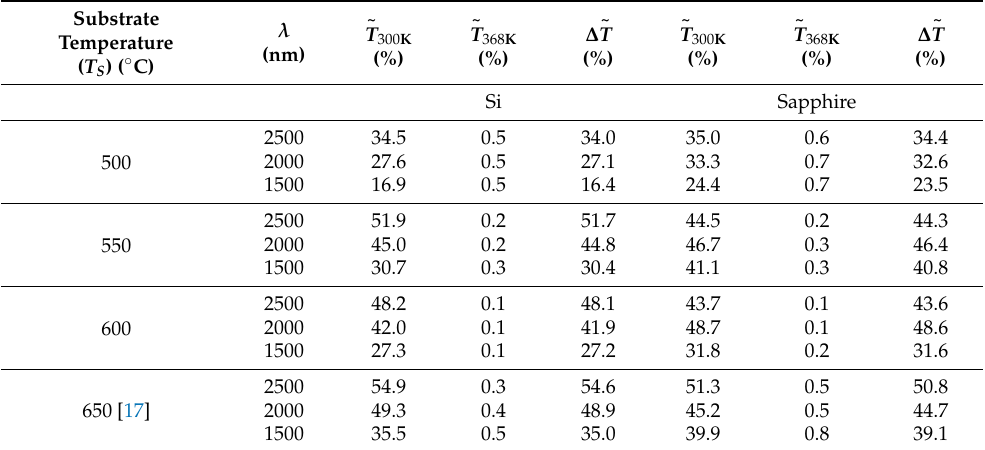
Table 3. Optical transmittance ( (cid:101) T ) and transmittance contrast ( ∆ (cid:101) T ) values of VO 2 films prepared at different substrate temperatures ( T S ) obtained at 300 K (insulating) and 368 K (metallic) for λ = 1500 nm, 2000 nm and 2500